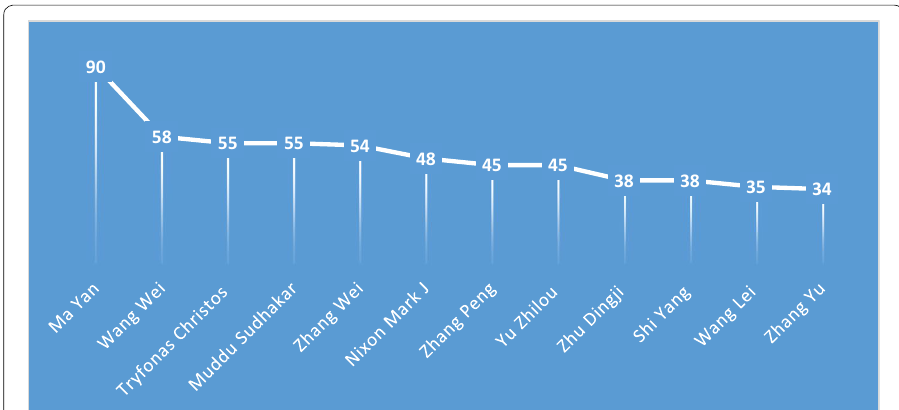
Fig. 5 The first 12 inventors with the largest number of